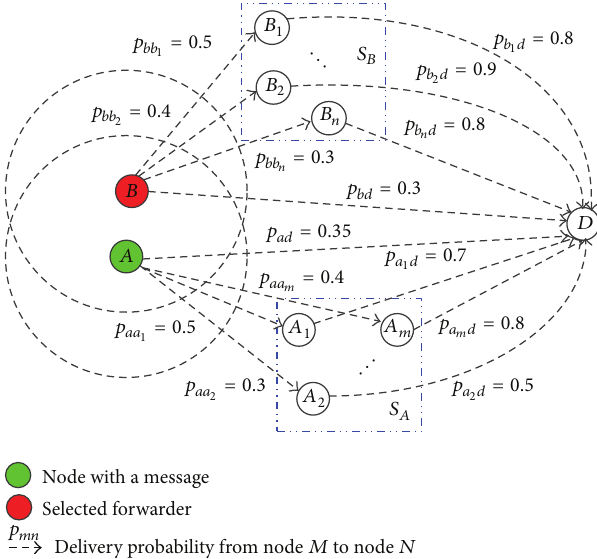
Figure 2: Two encountering nodes and their sets of nodes being encountered potentially in a DTN where 𝑝 𝑎𝑑 > 𝑝 𝑏𝑑 and 𝑝 𝑤 𝑏𝑑 > 𝑝 𝑤 𝑎𝑑